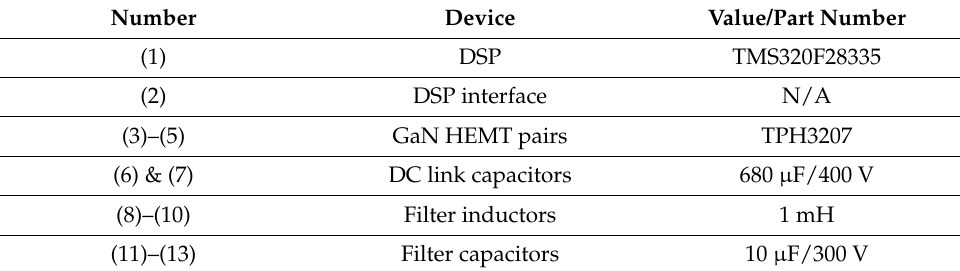
t 4 Figure 24. Implementation scenario: sequence diagram of reactive power command. 5.1. Test Results of Implementation Case 1: PI Controller In this case, only the PI controller is activated in the reactive power control loop. Measured results are presented in Figures 25–29. Figures 25 and 26 show that the phases and amplitudes of three-phase currents are well controlled. In Figures 27 and 28, it can be observed that the rise and fall times for reactive power were 4.3 ms and 4.68 ms, respec- tively, and the overshoot and undershoot percentages were 24% and 14%, respectively. In Figure 29, it can be observed that the PI controller was able to control the reactive power but the dynamic performance was not sufficient.